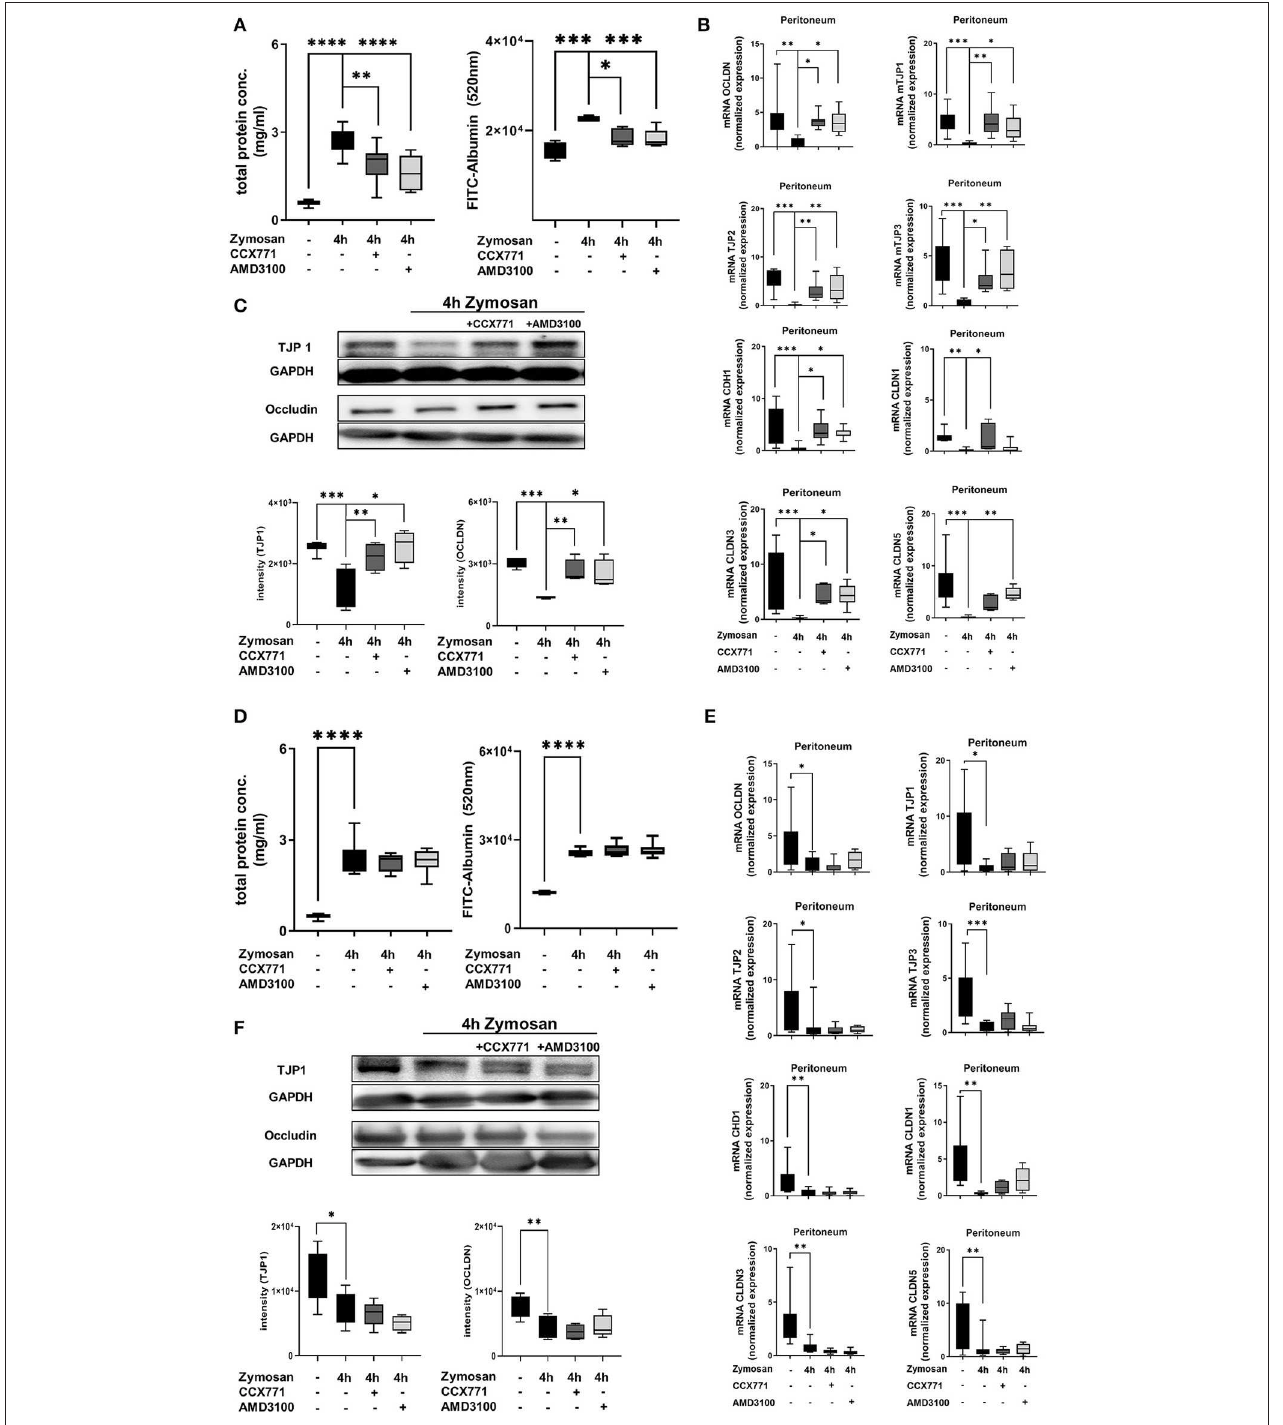
FIGURE 4 | Influence of CXCR4 and CXCR7 on microvascular permeability and cellular integrity. (A) Protein accumulation ( n = 6–12) and FITC-Albumin extravasation ( n = 4–6) were evaluated in the peritoneal cavity 4h after NaCl or zymosan injection in wild type and (D) A 2B –/– animals. Effects of AMD3100 or CCX771 on capillary leakage were determined. (B) Gene levels of integrity-related tight junction proteins like occludin (OCLDN), tight junction protein 1, 2, and 3 (TJP1; TJP2; TJP3), e-cadherin 1 (CDH1), claudin 1, 3, and 5 (CLDN1; CLDN3; CLDN5) were measured in peritoneal tissue of wild type ( n = 8–12) and (E) A 2B –/– animals ( n = 6–12). (C) Representative western blots of TJP1 and occludin protein of wild type and (F) A 2B –/– peritoneal tissue are shown (representatives blots of n = 3 experiments). Intensity of the blots was evaluated by ImageJ. For statistical analysis, one-way ANOVA was used with Bonferroni post-hoc test. Data are presented as box and whisker graph with error bars indicating the range from minimum to maximum value; * p < 0.05; ** p < 0.01; *** p < 0.001; **** p < 0.0001.